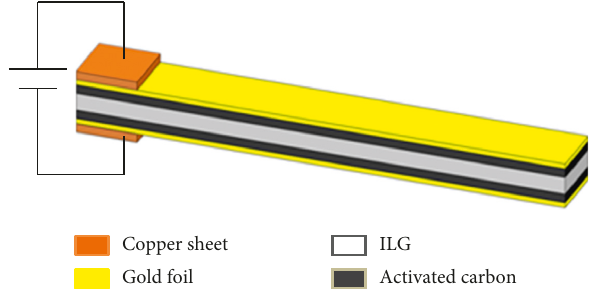
Figure 1: Five-layer structure of the soft actuator.